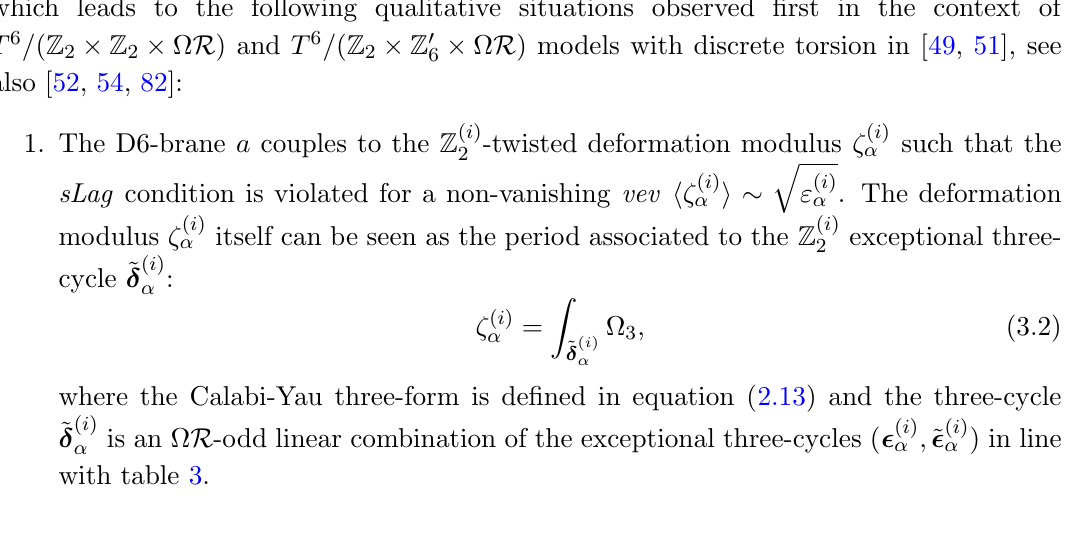
on T 4 = Z (3) and the fractional 2 2 (3)